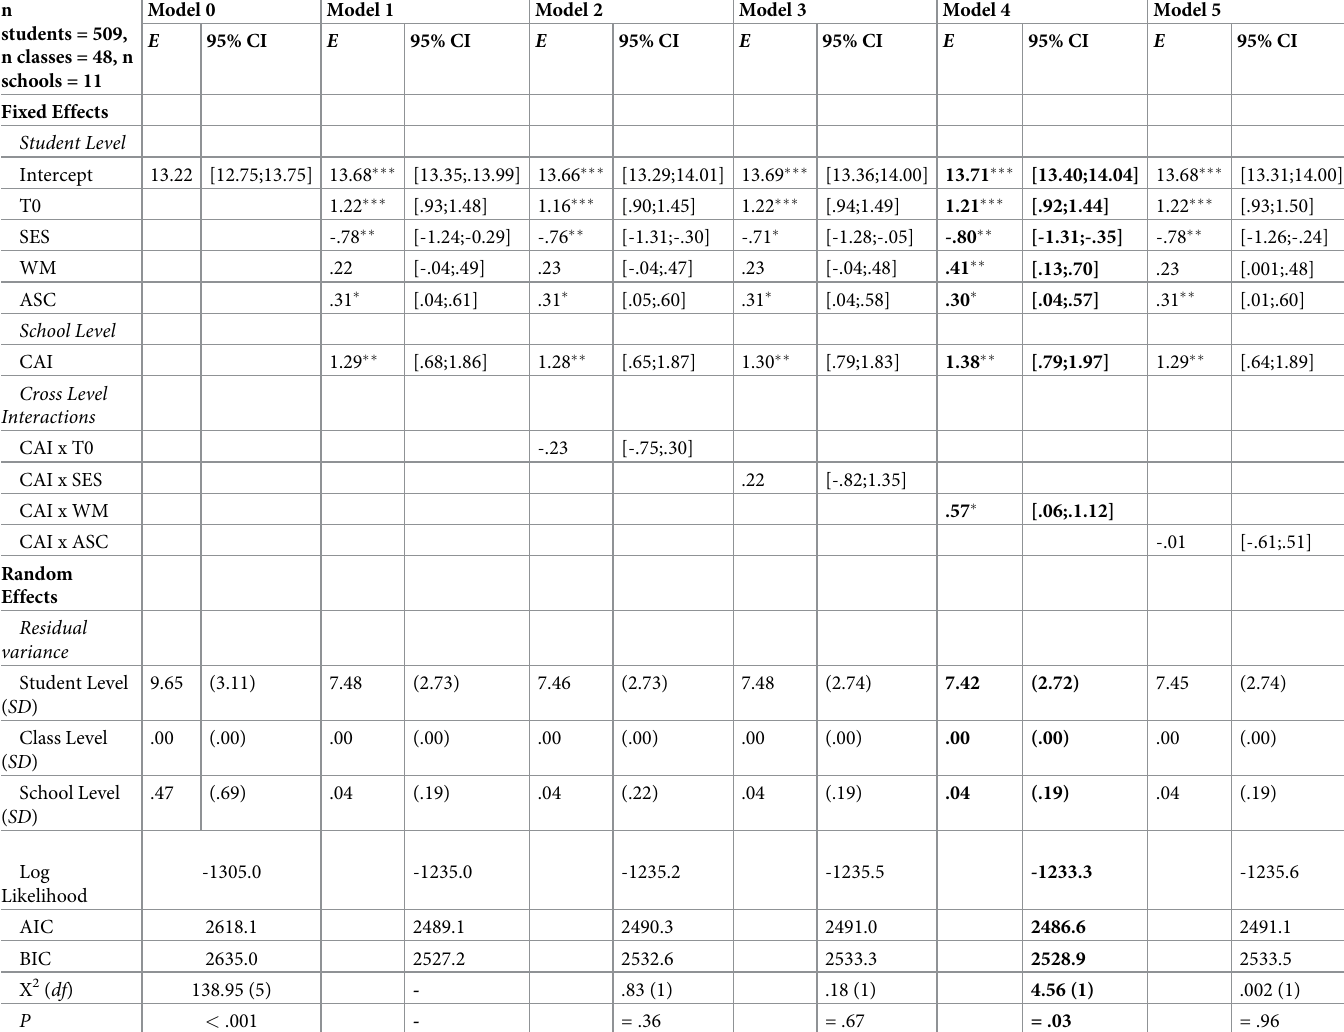
Table 1. Random intercept multilevel models in Sciences and Technology for the IBL vs. CAI